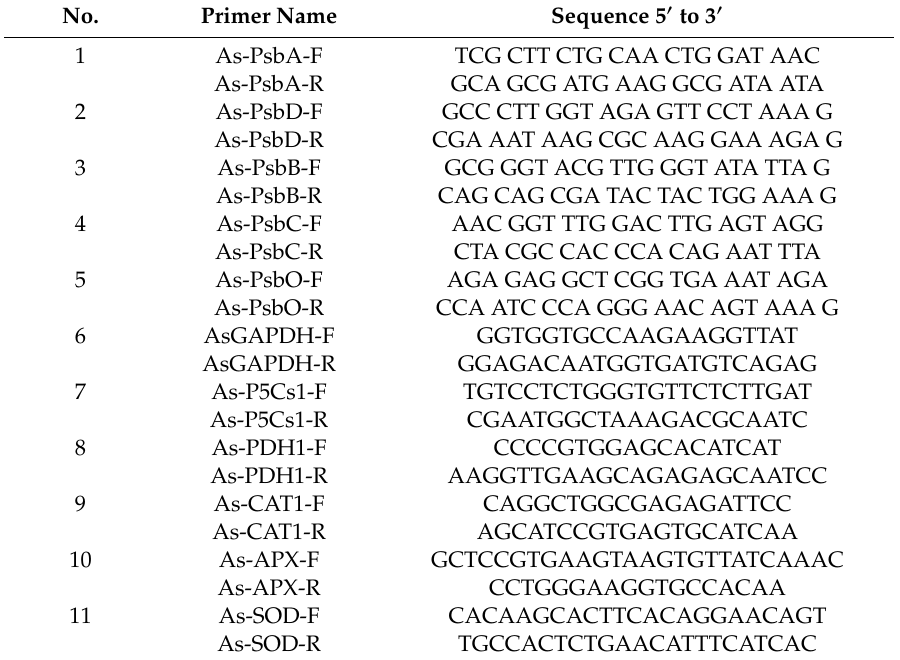
Table 1. Primers used in qPCR for amplifying 11 Avena sativa